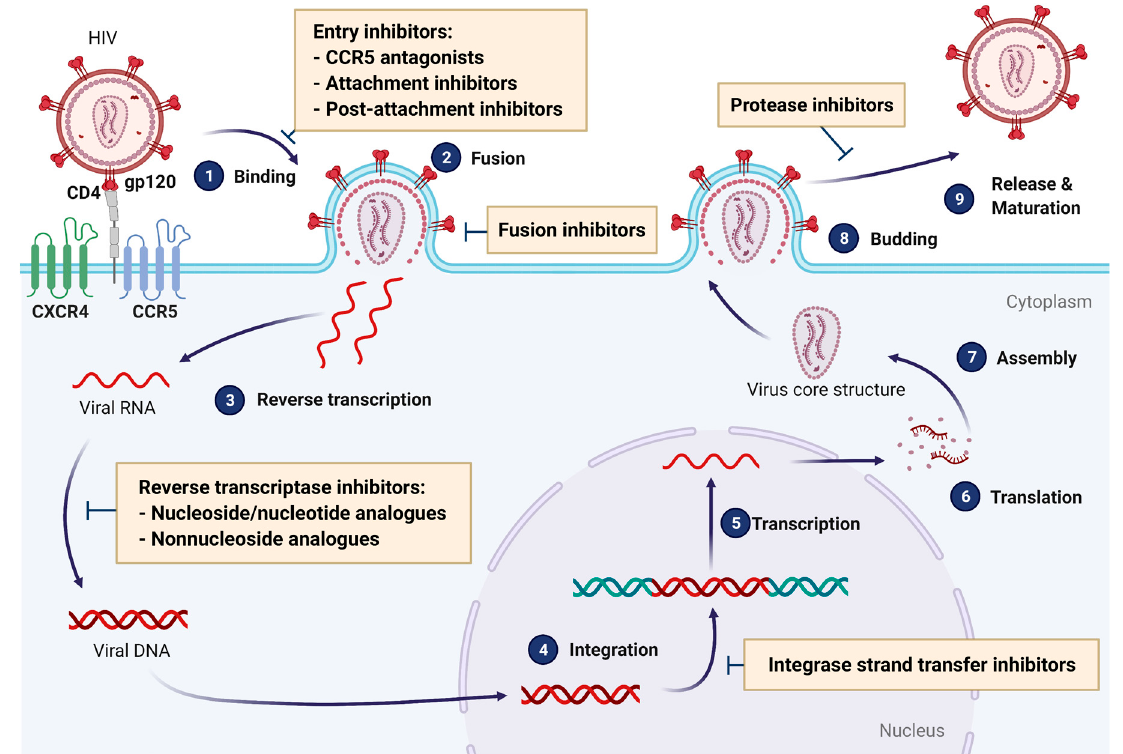
Figure 2. Available anti-HIV drug families and their mechanisms of action. Antiretroviral drugs include entry inhibitors, fusion inhibitors, nucleoside/nucleotide analogue reverse transcriptase inhibitors (N(t)RTIs), non-nucleoside reverse transcriptase inhibitors (NNRTIs), integrase inhibitors (INSTIs), and protease inhibitors (PIs). Entry inhibitors and fusion inhibitors prevent HIV from entering target cells by inhibiting its binding or its fusion, respectively. The exact mechanism involved varies depending on which receptor or complex formation is blocked: inhibition of CCR5 interaction with viral gp120 protein (CCR5 antagonists), blocking of viral gp120 (attachment inhibitors), or inhibition of the conformational changes of CD4/gp120 complex, which allow the binding to co-receptors (CCR5 or CCR4) (post-attachment inhibitors). N(t)RTIs, which can be either nucleoside or nucleotide analogues, function by inhibiting the synthesis of DNA by reverse transcriptase, the viral enzyme that copies viral RNA into DNA in newly infected cells, acting as false nucleotides. NNRTIs also inhibit the synthesis of viral DNA, but by binding to and inhibiting the reverse transcriptase in a non-competitive way. INSTIs inhibit the viral integrase, thus impeding the incorporation of reverse-transcribed HIV DNA into host cell DNA. Finally, PIs bind to the active site of the viral protease enzyme, preventing the processing of immature viral proteins into their functional conformations and the generation of new viral particles.